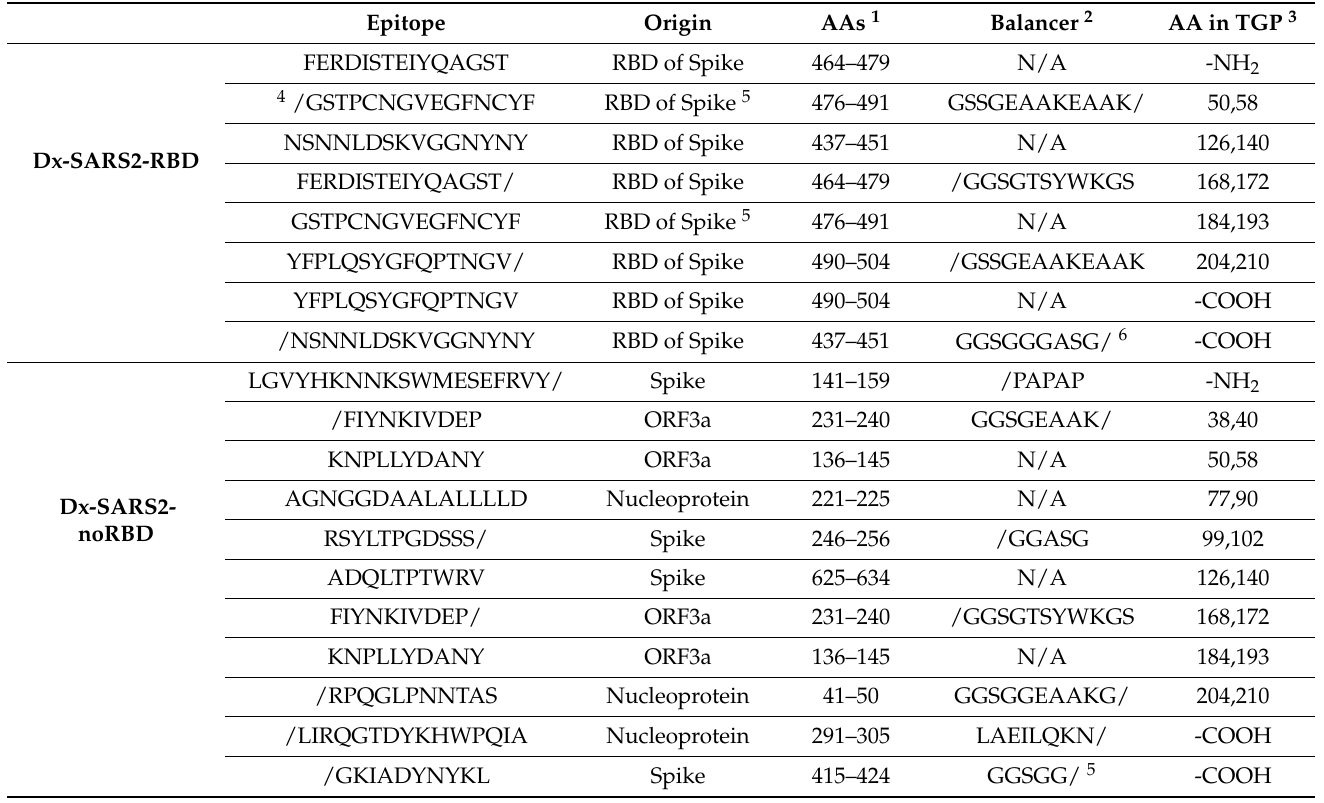
Table 1. Epitopes, their origin, balancers, and the insertion site in TGP used to engineer Dx-SARS2-RBD and Dx-SARS2-